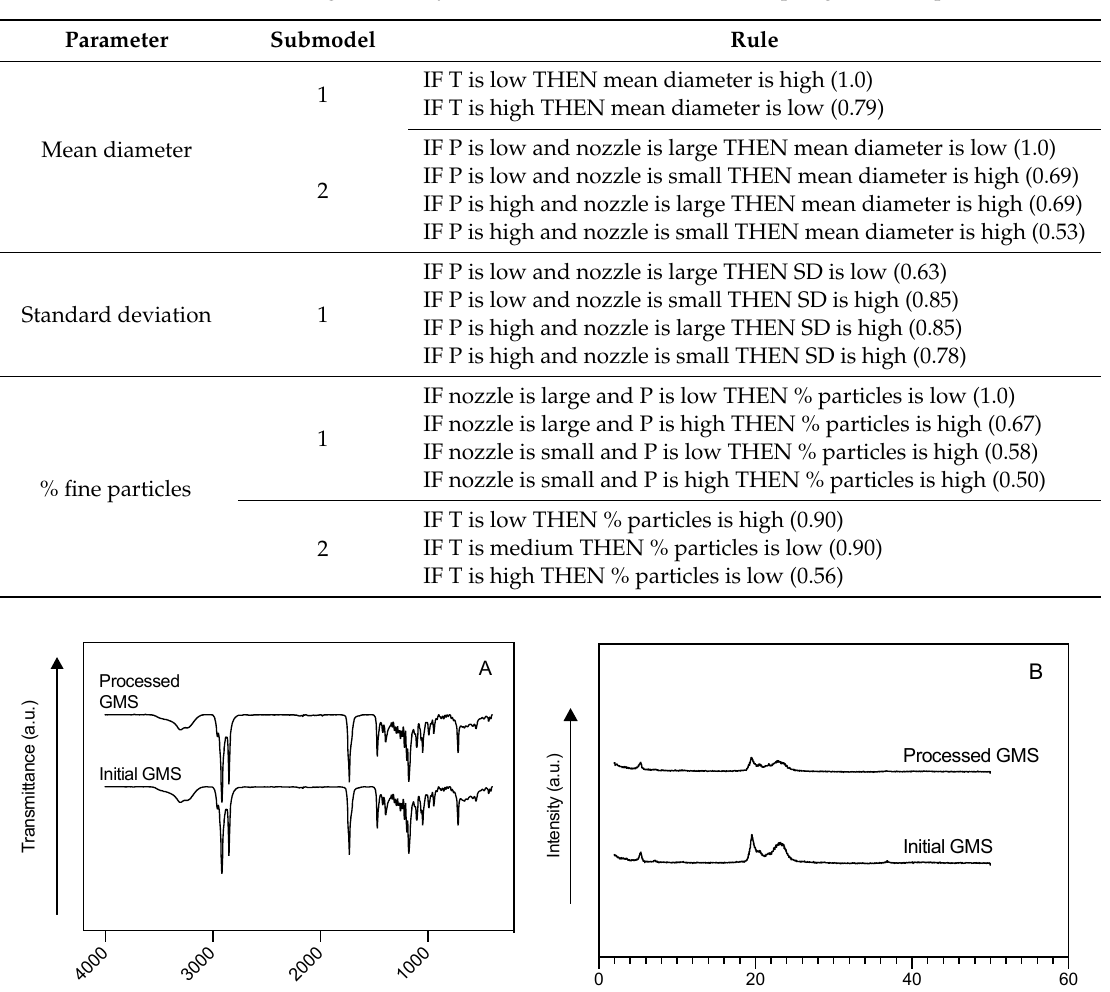
Table A1. IF ... THEN rules generated by FormRules ® software. Membership degrees are in parenthesis. Table A1. IF…THEN rules generated by FormRules ® software. Membership degrees are in